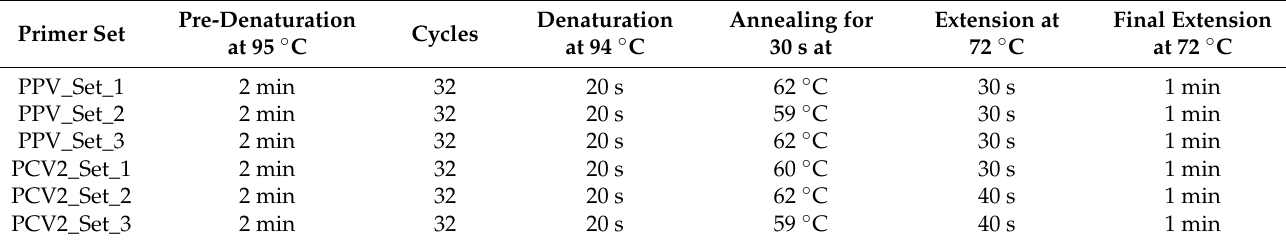
Table 2. Cycling conditions for each primer